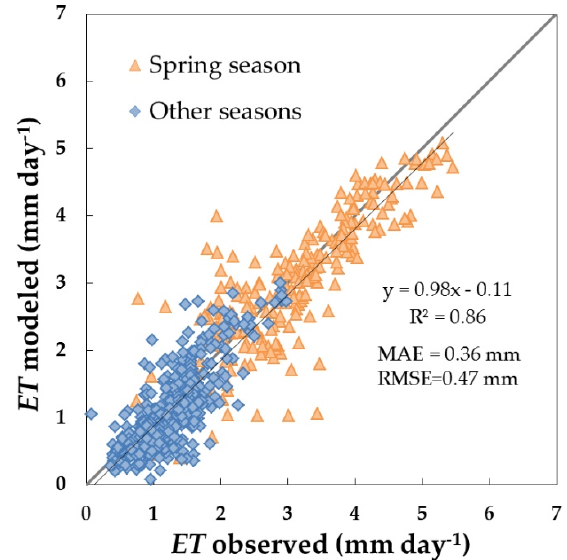
Figure 5. Comparison between observed and modeled daily evapotranspiration ( ET ) values (mm) for the dehesa system (tree + grass) for the four hydrological years analyzed (between 2013–2014 and 2016–2017). Root Mean Square Error (RMSE) and Mean Absolute Error (MAE) are presented in the